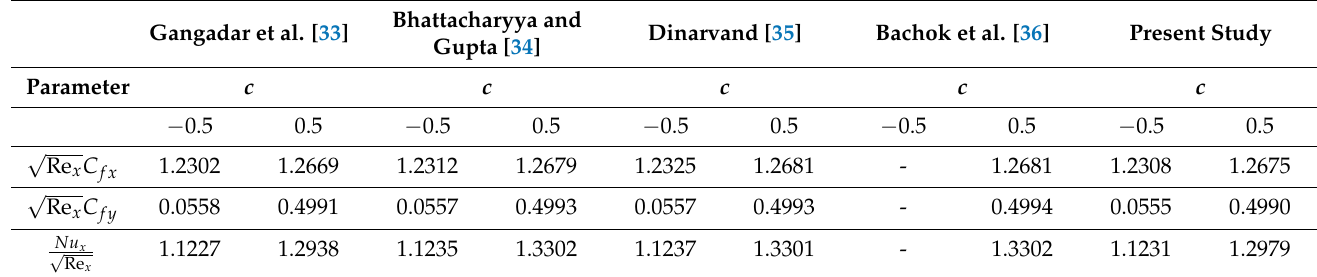
Table 2. Numerical validation for various values of c in the absence of S , λ , φ 1 , and φ 2 .